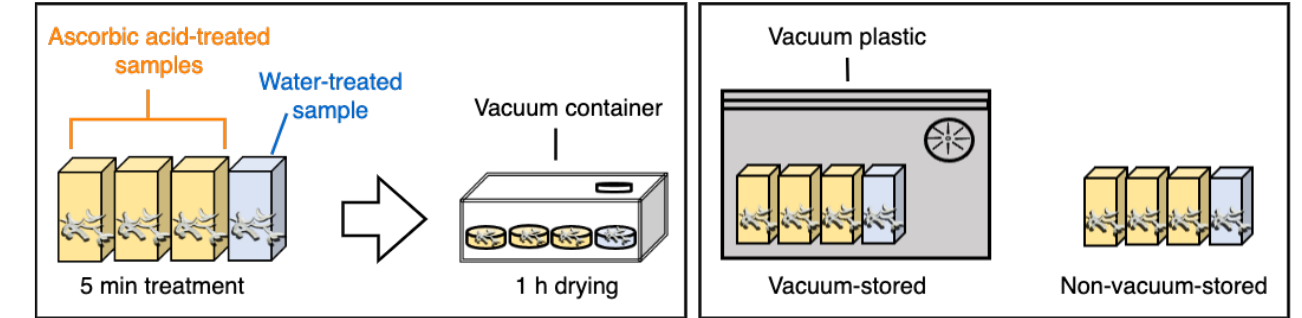
Figure 2. Example illustrations of the treatment procedure of the samples followed by drying inside a vacuum container ( left ) and the storage procedure in two different mediums: vacuum and non-vacuum ( right ).